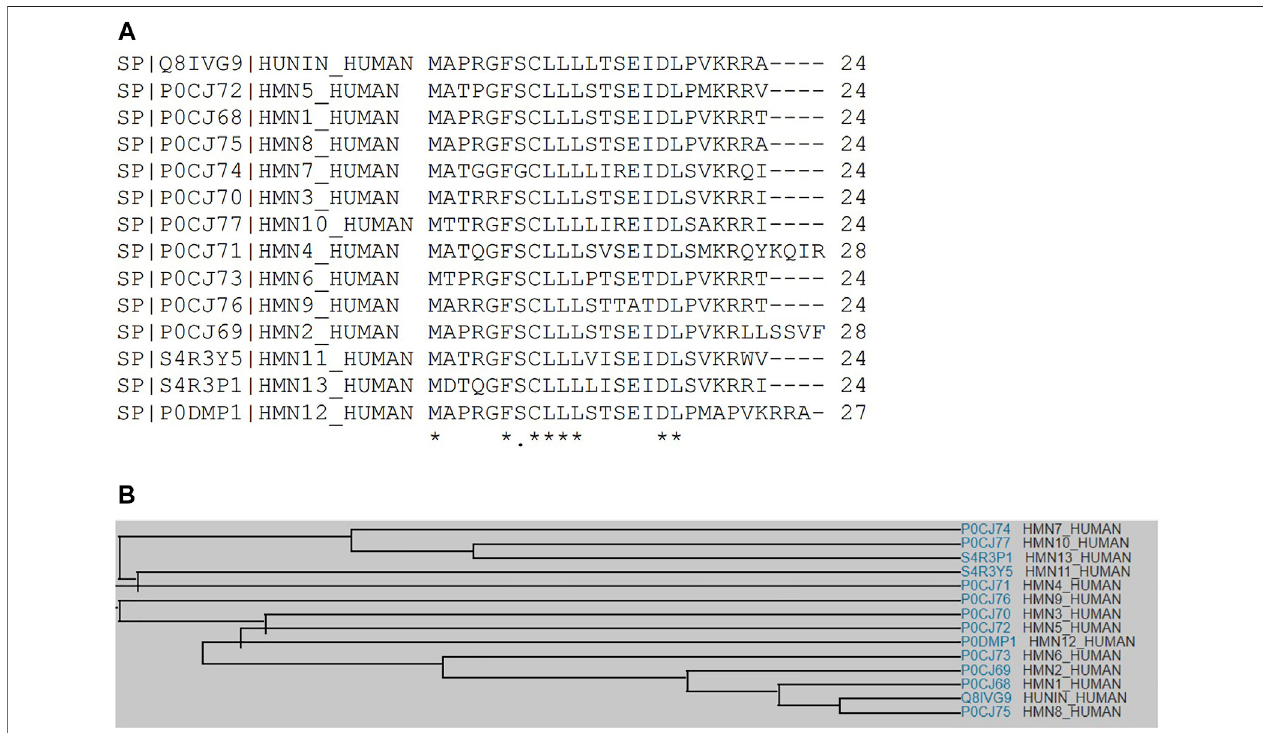
FIGURE1 |(A) Multiple sequence alignmentanalysesshow that HN shares amino acidsequence identity and similaritywith other HN-like proteins, MTRNR2L1 to MTRNR2L13. (B) A family tree of HN proteins and HN-like proteins is presented.